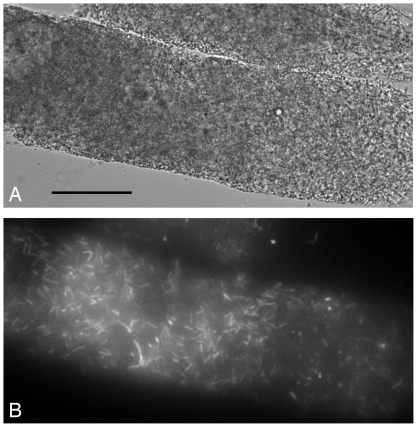
Infection of C. elegans by B. anthracis-gfp in presence of B. thuringiensis expressing Cry5B spores (non-gfp) and B. anthracis-gfp spores.(A) Transmitted-light view of the worm cuticle filled with vegetative and sporulated Bacillus. (B) View of the same worm using the fluorescence light: rod-shaped bacteria expressing GFP are visible, indicating that B. anthracis is capable of infecting C. elegans in presence of Cry5B expressing-B. thuringiensis. In this animal and all similar animals examined, the vast majority of bacteria inside the nematode cuticle were GFP positive. Scale bar is 50 µm.